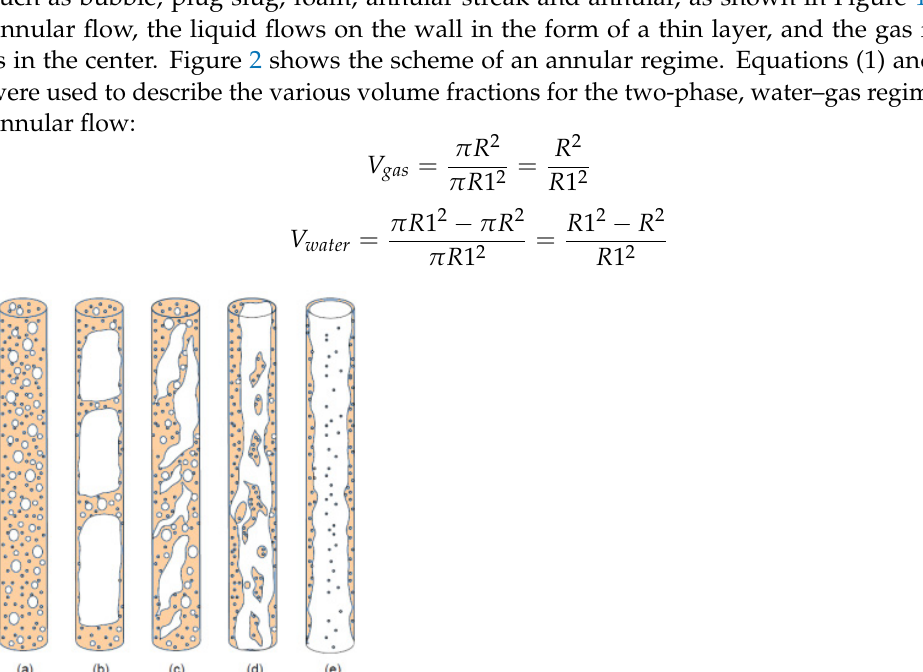
Figure 1. ( a ) Bubble flow, ( b ) Plug slug flow, ( c ) Foam flow, ( d ) Annular streak flow, ( e ) Annular flow.